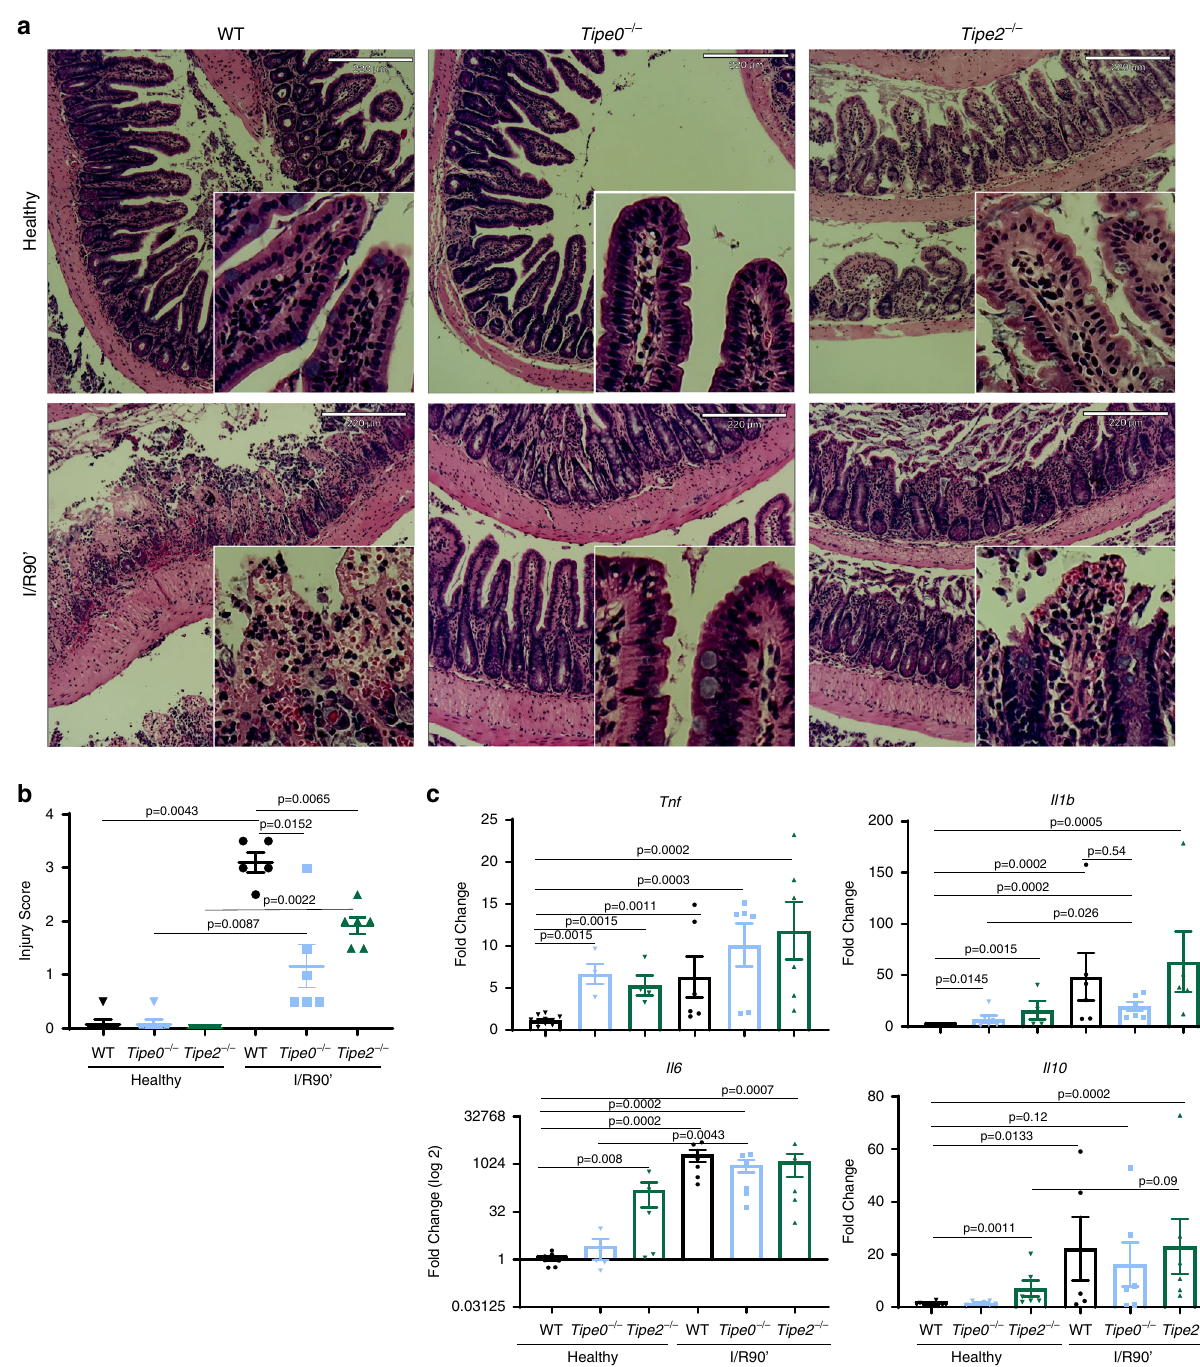
Fig. 1 Loss of TIPE0 or TIPE2 results in protection from intestinal ischemia/reperfusion injury. a Representative histological images and b Blinded histology scores in mice subjected to I/R90 ′ , with adjacent healthy tissue as a control. N = 5 mice/group for WT & Tipe0 − / − I/R90 ′ ; N = 6 mice/group for all other groups; bars = 220 μ m; inserts are magni fi ed 4×. Images are representative of the mean damage score for each condition. c RT-PCR, N = 4 – 7 mice/group, except for WT healthy N = 11 mice. For all panels p is as indicated on the fi gure. Error bars are mean ± SEM. Multiple group comparisons were by Kruskal – Wallis one-way ANOVA. Two-tailed Mann – Whitney U test was used to con fi rm ANOVA fi ndings. Source data are provided as a source data fi